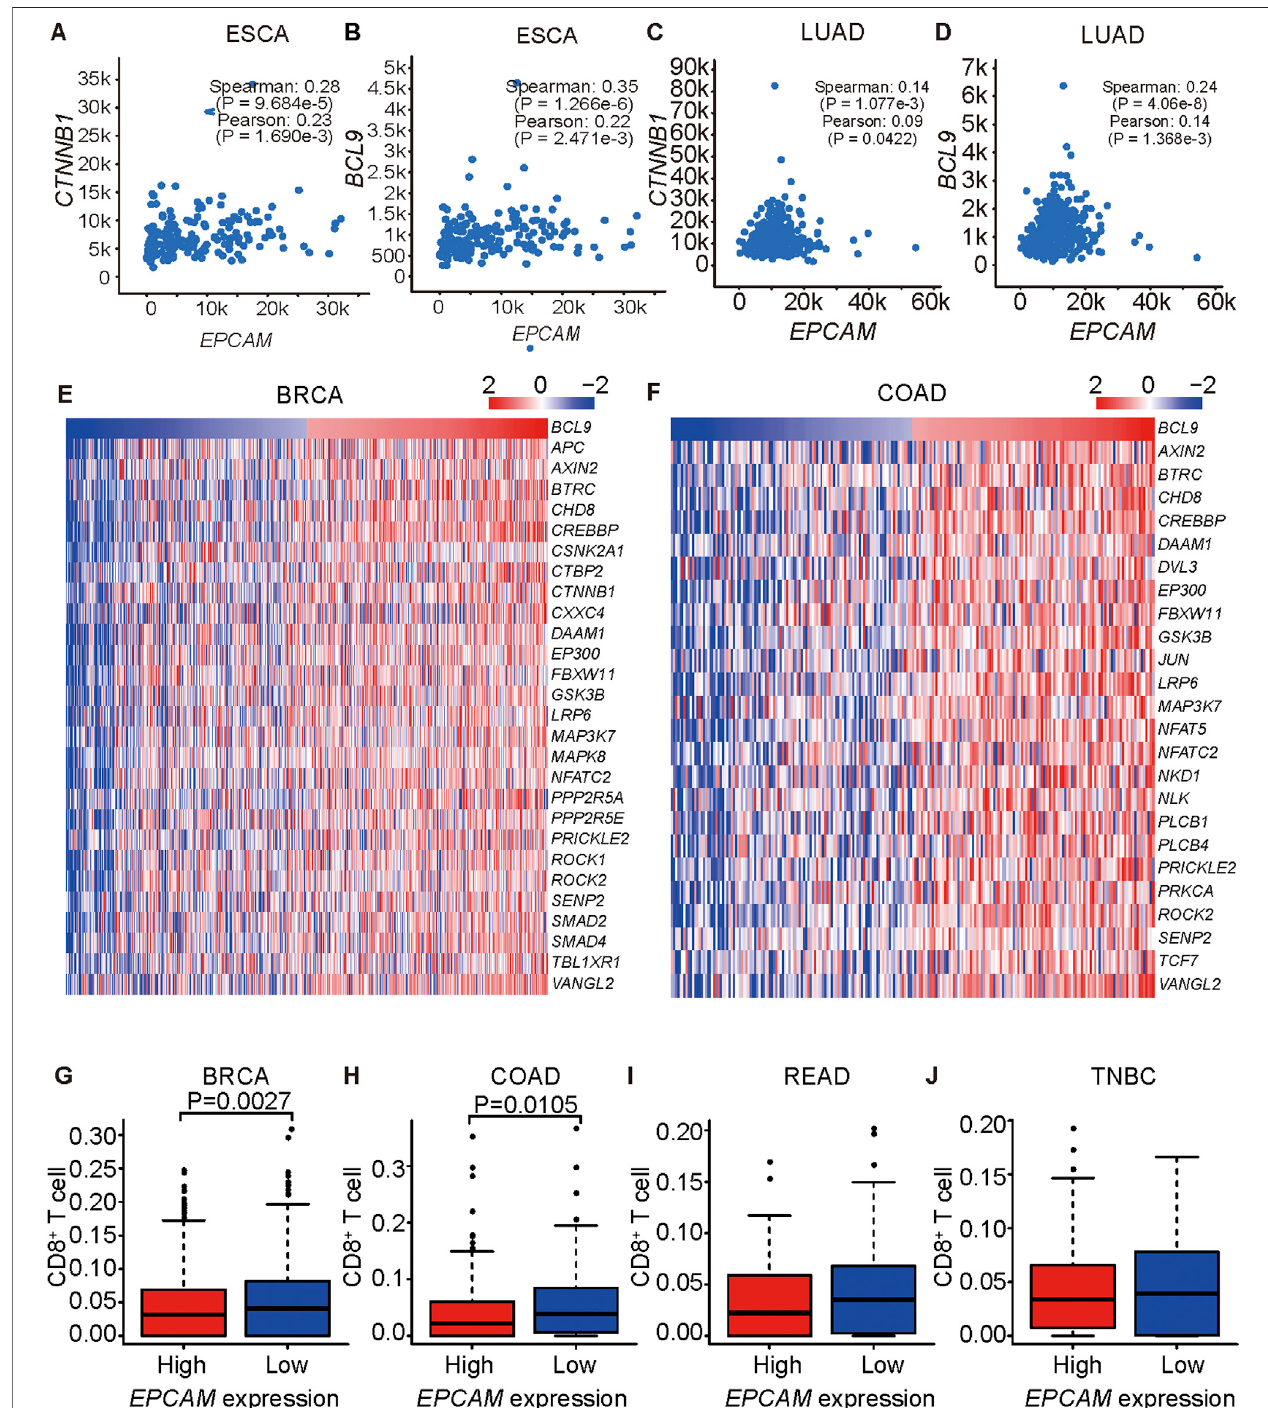
FIGURE 2 | EPCAM expression is correlated to BCL9 and CTNNB1 expression. (A – H) Correlation analysis of EPCAM and BCL9 expression level, EPCAM and CTNNB1 expression level in ESCA (A, B) , LUAD (C, D) . (E – F) TGF β signaling pathway genes are correlated with BCL9 in BRCA (E) , COAD (F) of TCGA. (G – J) CD8+ T cells are associated with EPCAM expression level in BRCA (G) , COAD (H) , READ (I) , TNBC (J) of TCGA.